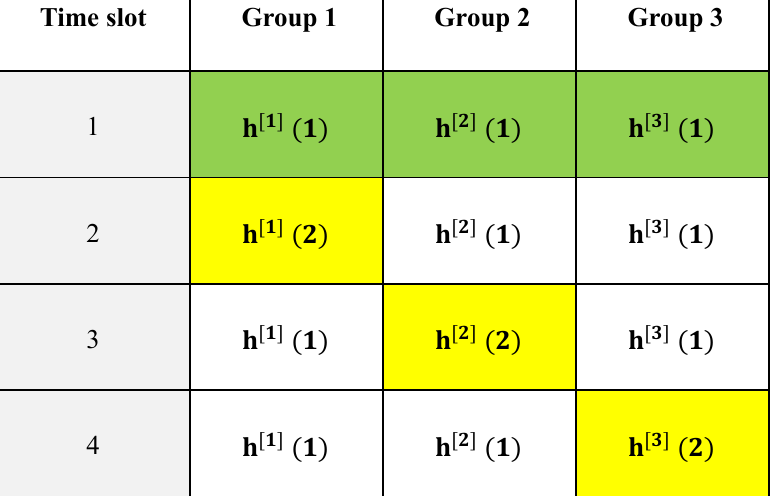
Figure 2. The supersymbol of BIA for a VLC network with L = 2 transmitters and G = 3